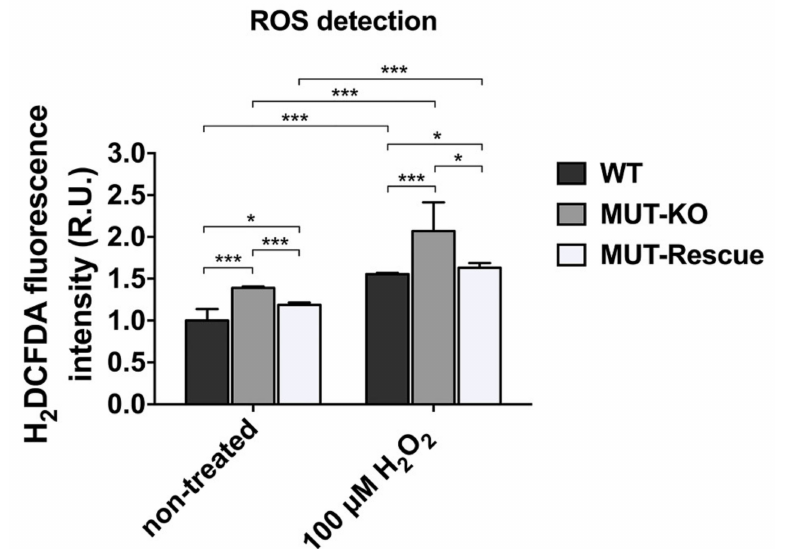
Figure 8. Determination of intracellular ROS levels. Non-treated and H 2 O 2 -treated WT, MUT-KO, and MUT-Rescue cells were analyzed by the H 2 DCFDA fluorescence assay. Fluorescence intensity values were obtained through three technical measures in three independent biological replicates. The averages of technical replicates measures were normalized to the total protein amount of each sample. Normalized values were expressed as fold change (relative units, RU) with respect to WT control cells and reported as mean values of the three replicate experiments whereas error bars represent SD. A one-way two-tail paired t -test was used to calculate the statistical significance of di ff erences between the three cell types and in both treatment conditions. *: p < 0.05; ***: p <